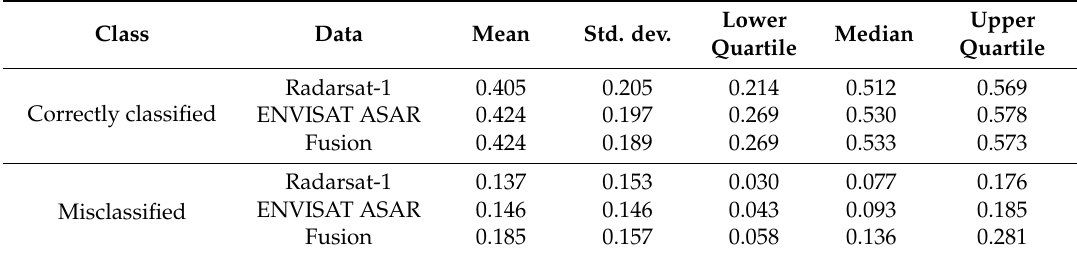
Table 6. Summary statistics of DCI values at the correctly and incorrectly classified reference pixels for different classification